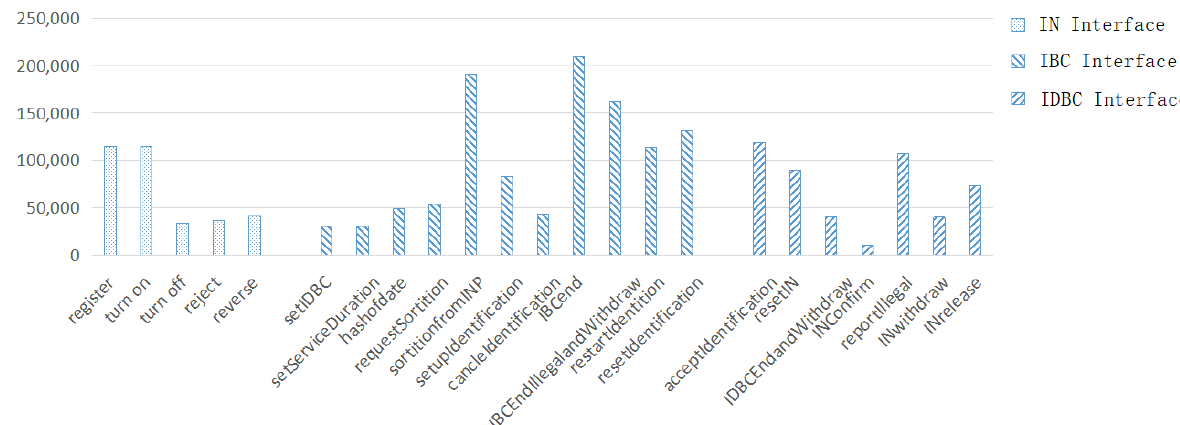
Figure 4. Gas consumption of each interface.